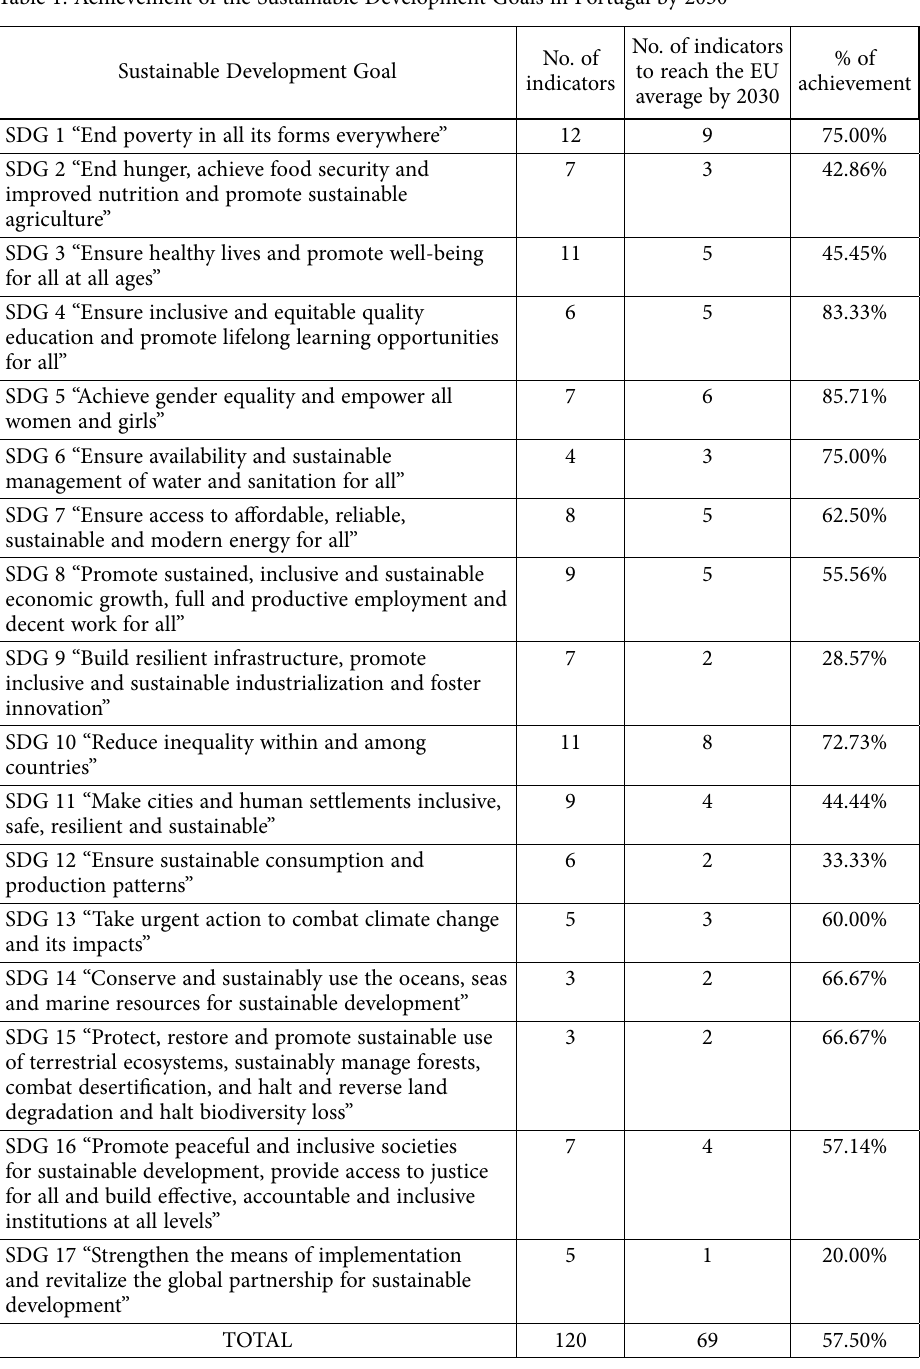
No. of indicators % of No. of to reach the EU achievement indicators average by 2030